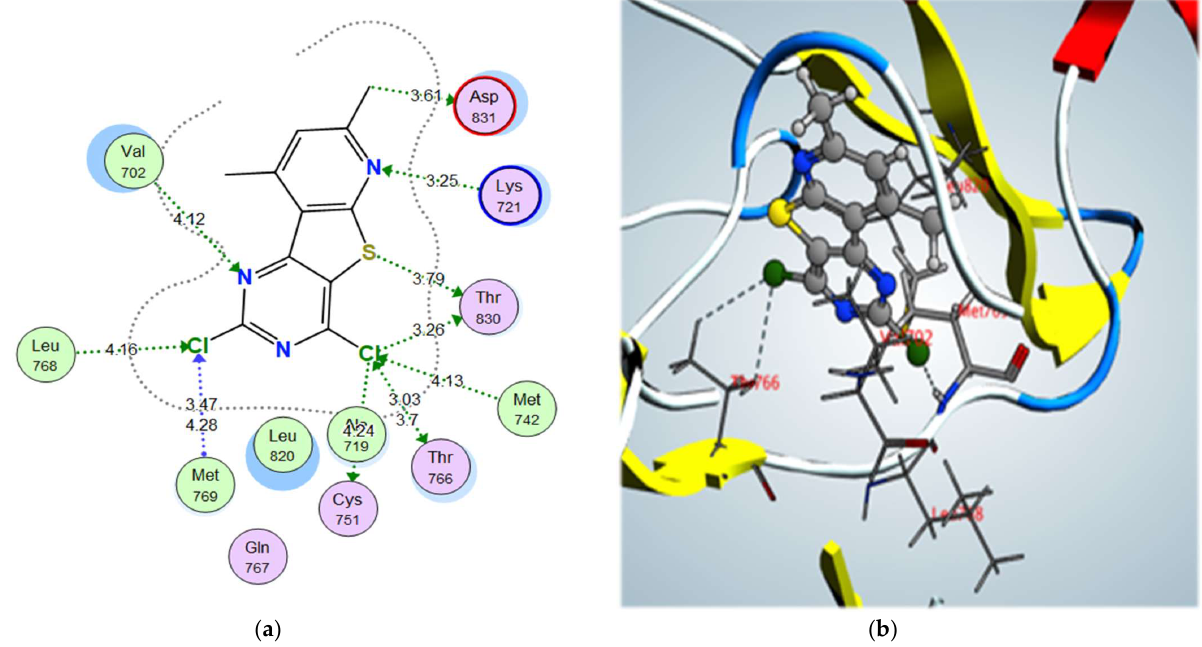
Figure 9. ( a ) 2D interactions and ( b ) 3D interactions of compound 3a within the EGFR kinase do- main’s active site.